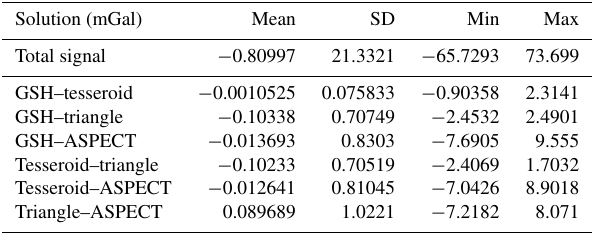
Table 4. Statistical results from the WINTERC-G-grav